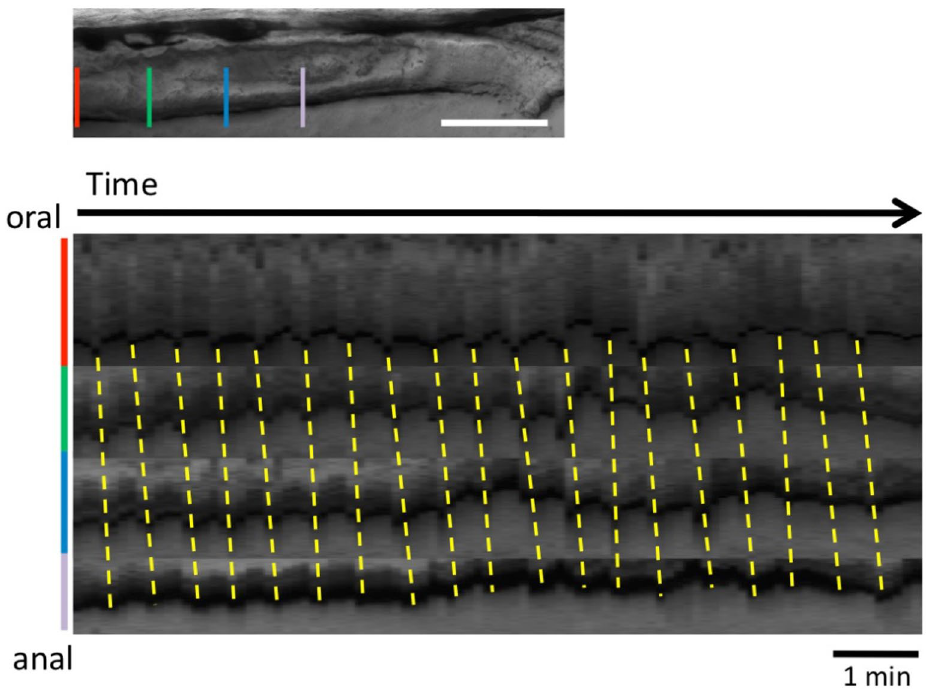
Figure 4. Posterior propagation of the regular movements, that is distinct from the peristaltic reflex, observed in the distal intestine of zebrafish larva at 8 dpf with a bolus. Kymographs of the bright field movie at four positions in the distal intestine (colored lines in the upper panel) along the anterior–posterior axis, from the data shown in Fig. 2 (20 min duration; Also see Supplementary video 1). Dotted lines demonstrate that the waves of periodic contractions propagate in the caudal direction. These regular movements may correspond to slow waves. See the text for the detail. Scale bar, 50 μm.